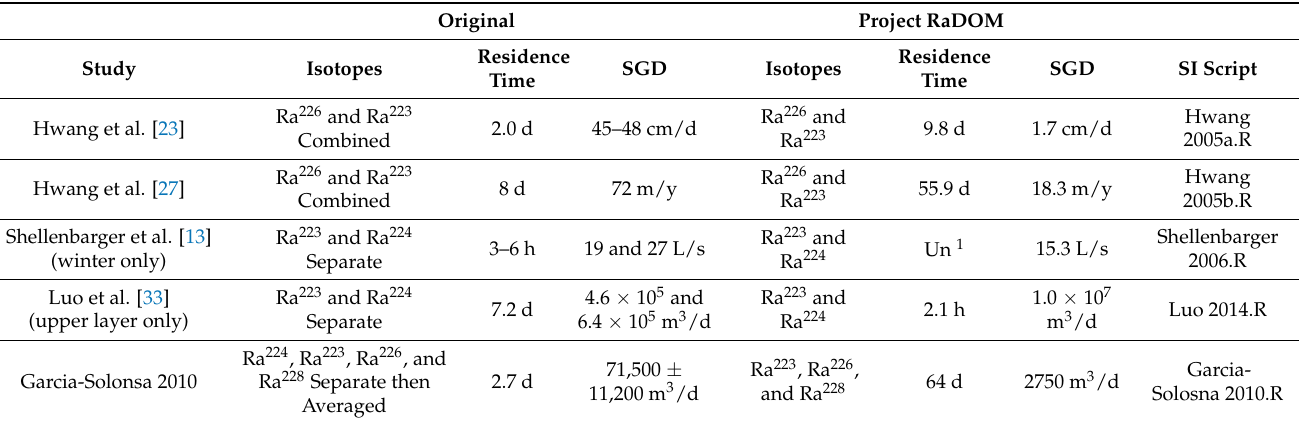
Table 1. Comparison of results of original box models and Project Open RaDOM models using the same data. Project RaDOM units were converted to the units of the original